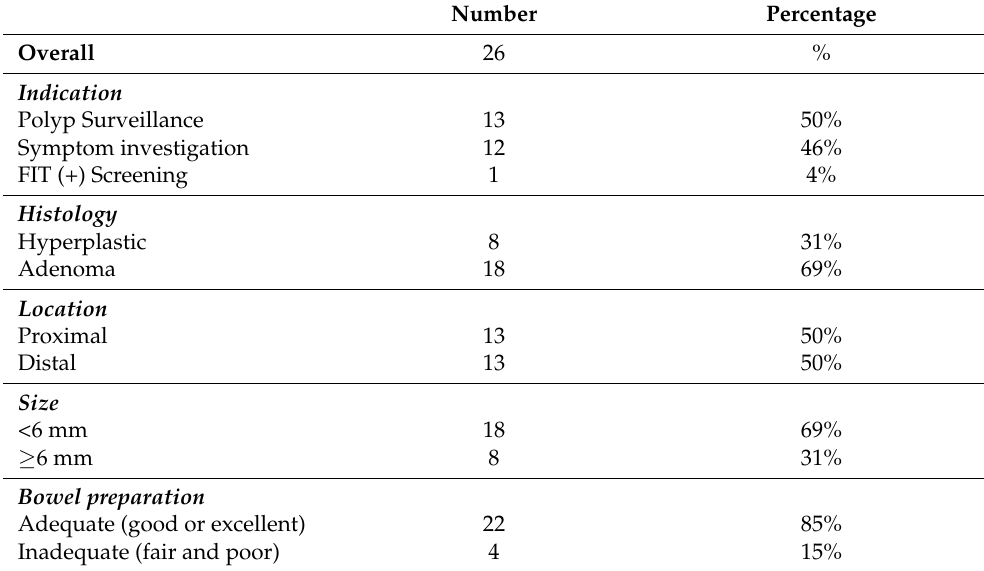
Figure 1. Polyps seen on CCE re-reading. Table 2. False Negative CCE Characteristics.